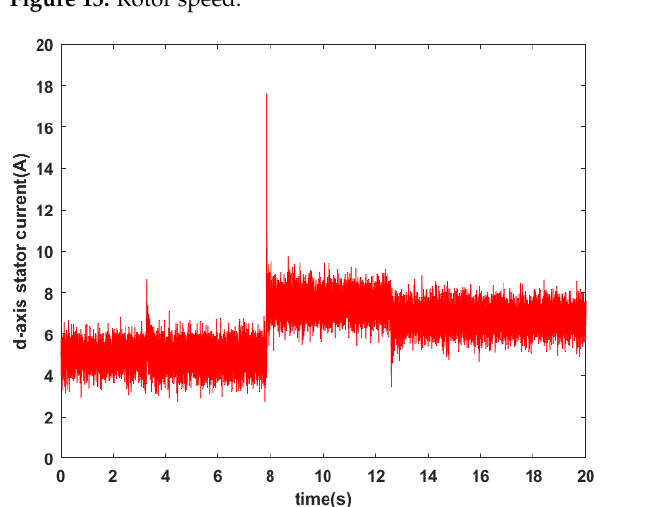
Figure 13. Rotor speed.